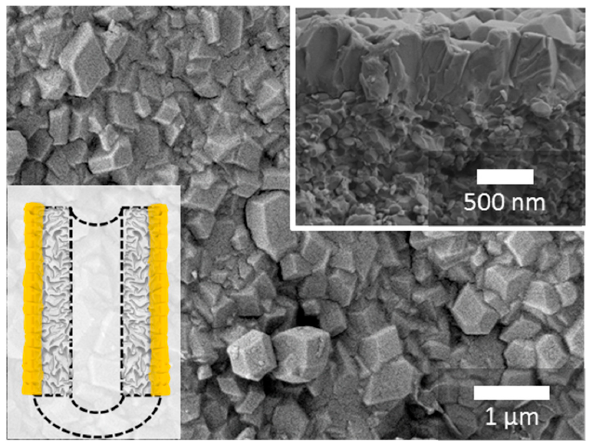
Figure 6. Top-view and cross-section (inserted) SEM micrographs of ZIF-8 membranes on the shell side of tubular supports. The secondary growth was performed at 30 °C for 6 h.